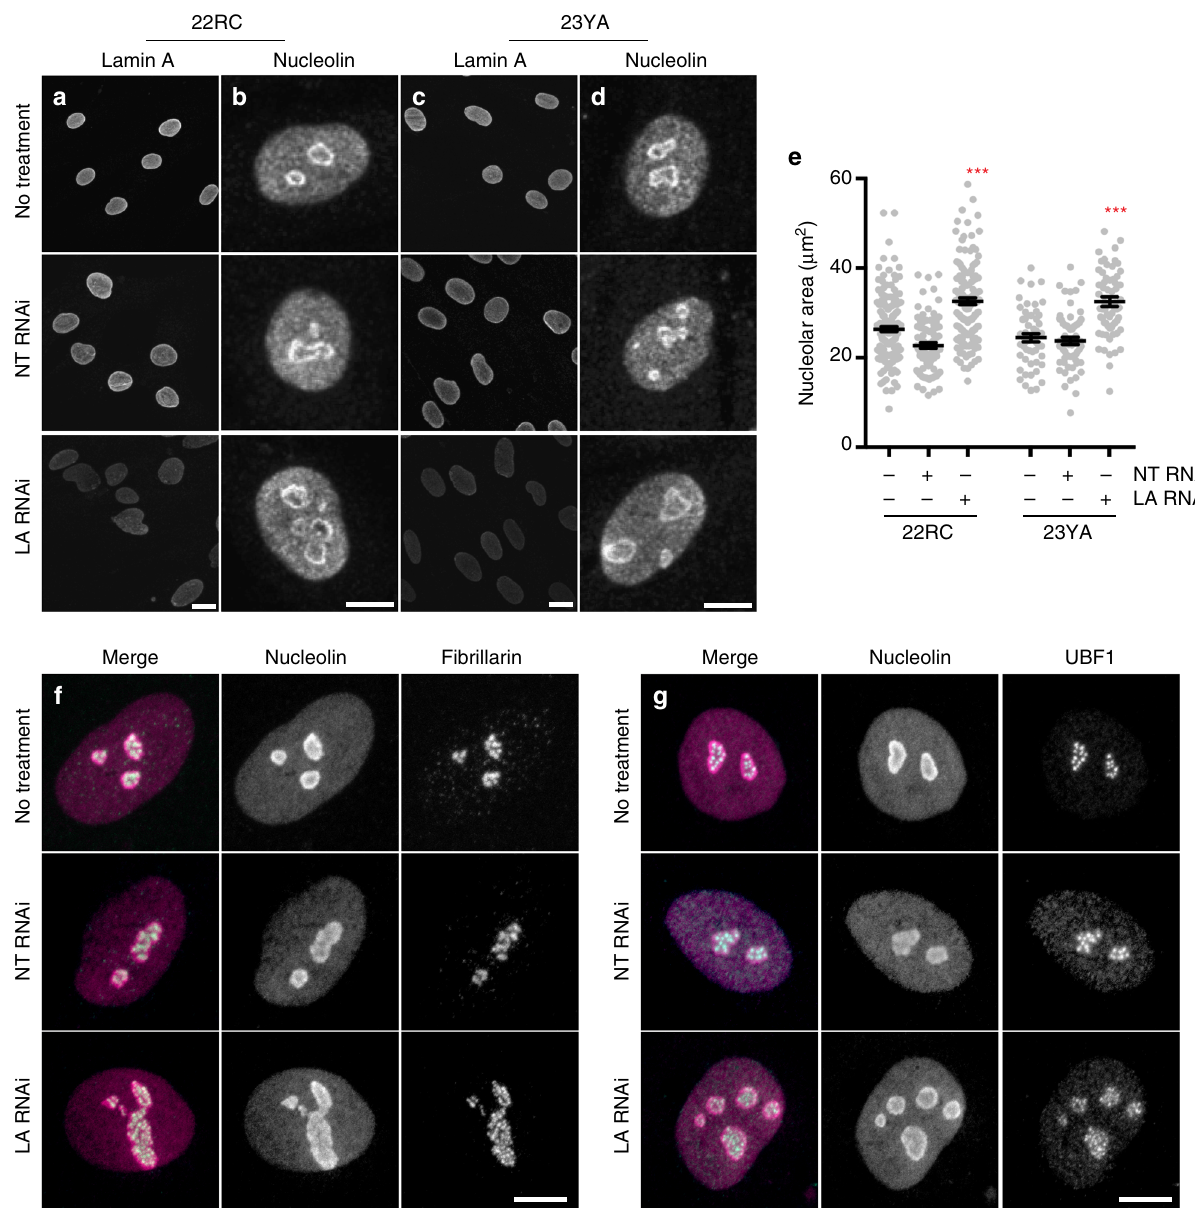
Fig. 6 Lamin A depletion drives nucleolar expansion. a – e Normal human fi broblasts (22RC and 23YA) transfected as indicated with non-targeting (NT) or Lamin A/C-targeting (LA) RNAi for 72 h before staining for Lamin A/C a , c or nucleolin b , d . Scale bar = 20 μ m a , c ; 10 μ m b , d . e Total nucleolar area per cell, determined by boundaries of nucleolin immuno fl uorescence. Signi fi cance determined by t -test. Black bars indicate mean ± SEM for N > 52 cells per condition from two independent experiments with two technical replicates. f , g Normal human fi broblasts (22RC) transfected as indicated with NT or LA RNAi for 72 h before staining for nucleolin ( magenta ) and fi brillarin ( cyan ) f or UBF1 ( cyan ) g . Scale bar = 10 μ